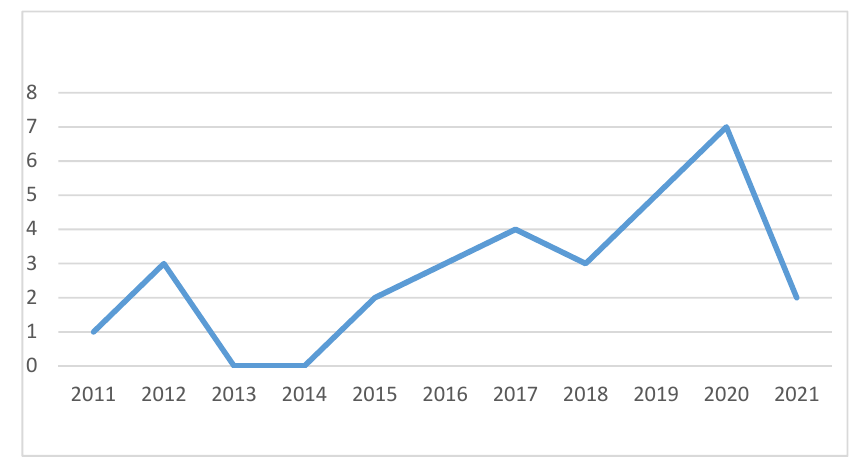
Figure 2. Distribution of the selected papers by the year of publication.